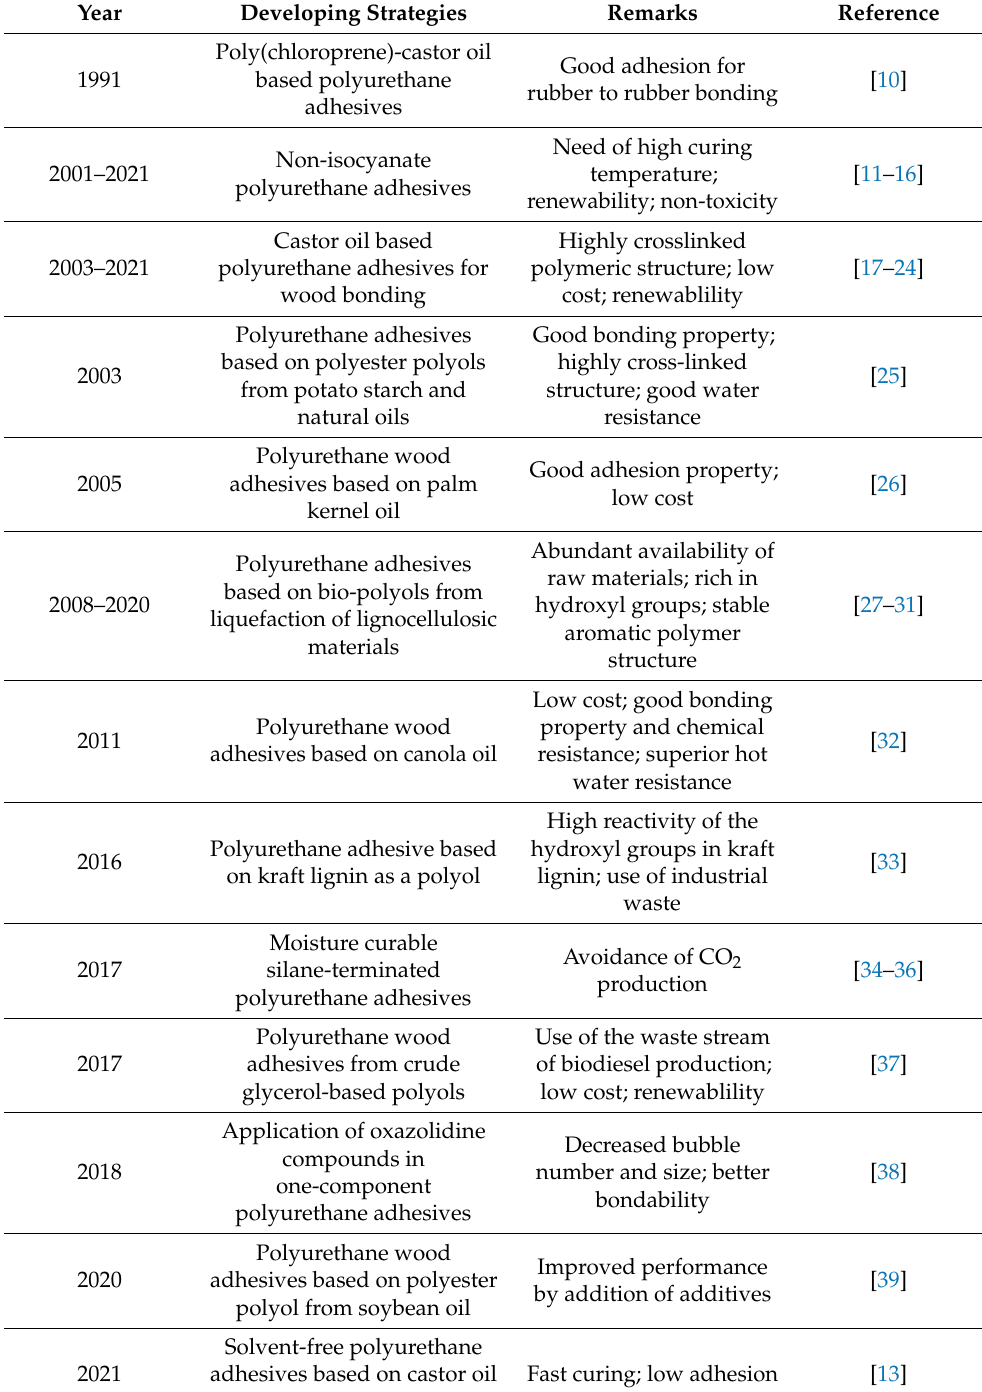
Table 1. Development of bio-based polyurethane